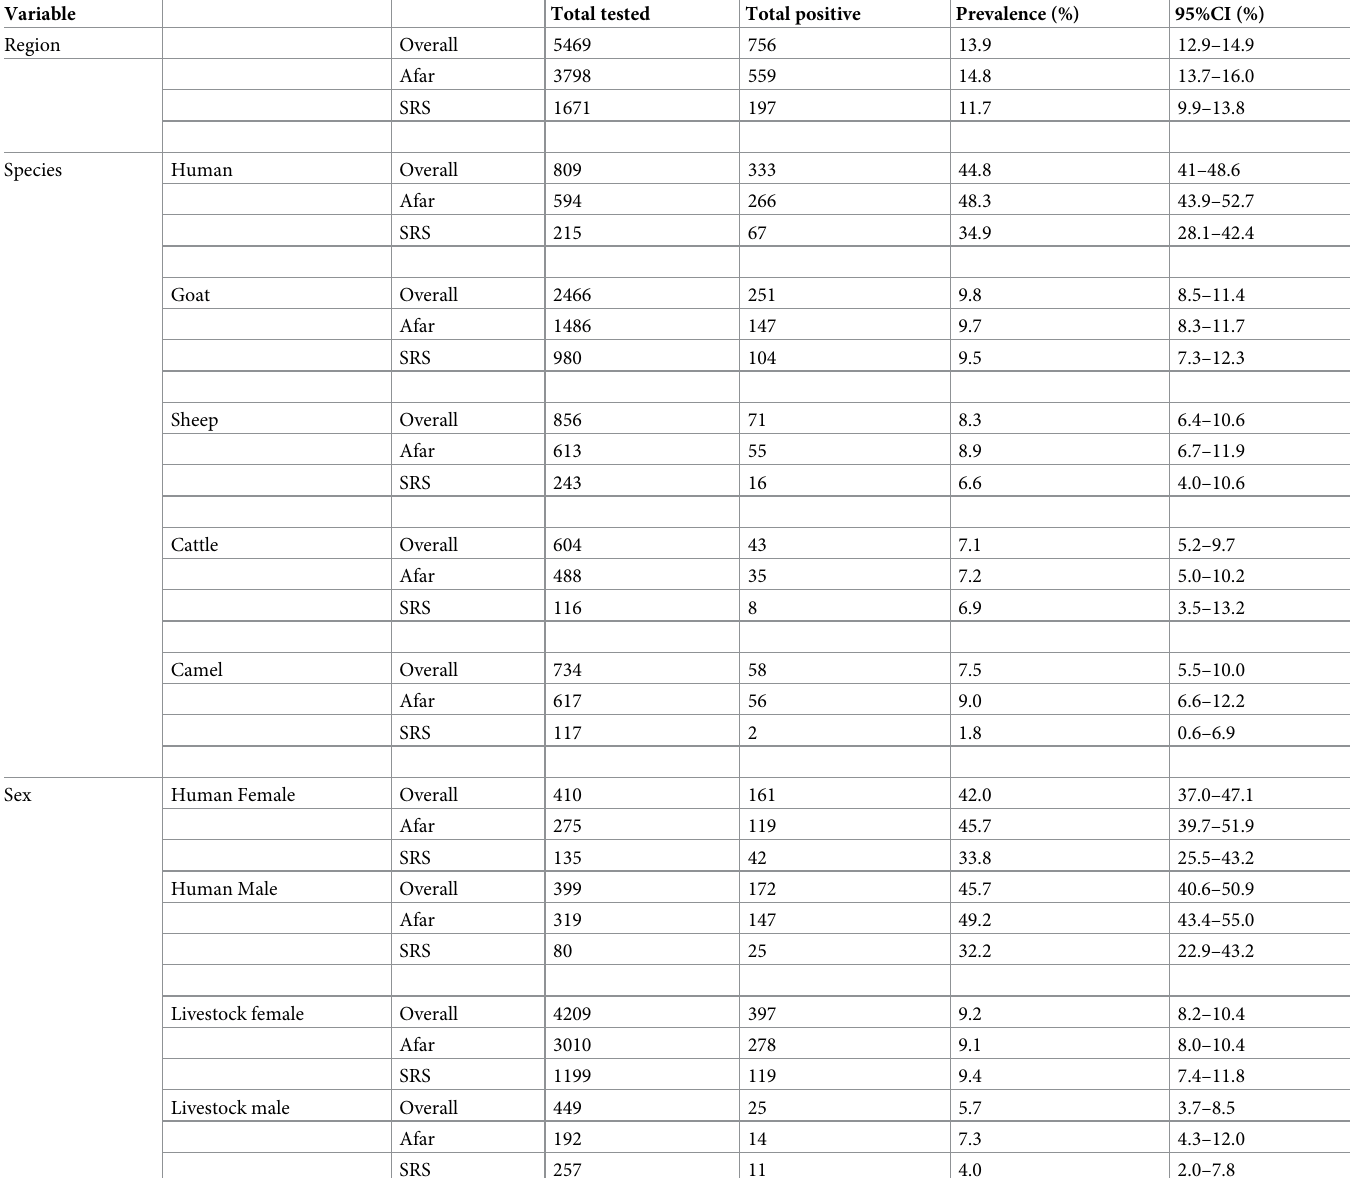
Table 1. Sero-prevalence of brucellosis by region, detailed species and sex (using a GEE model). Variable